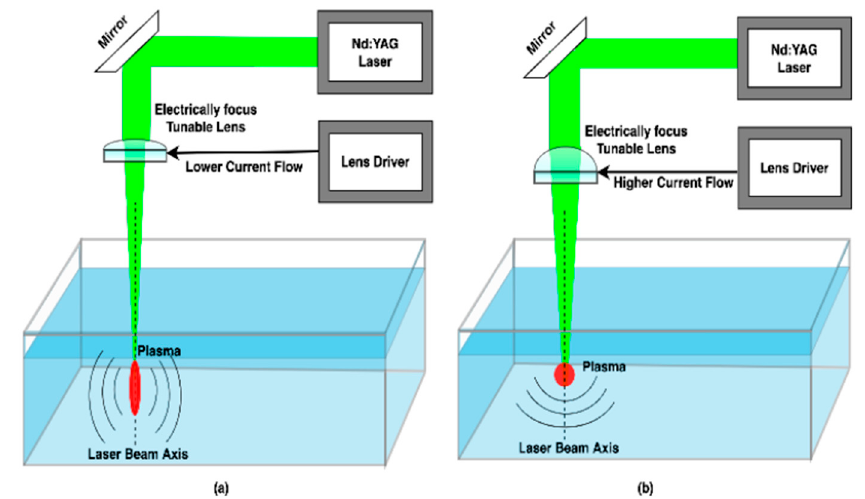
Figure 14. The use of electronically focus-tunable lens to create ( a ) cylindrical and ( b ) spherical shape plasma.